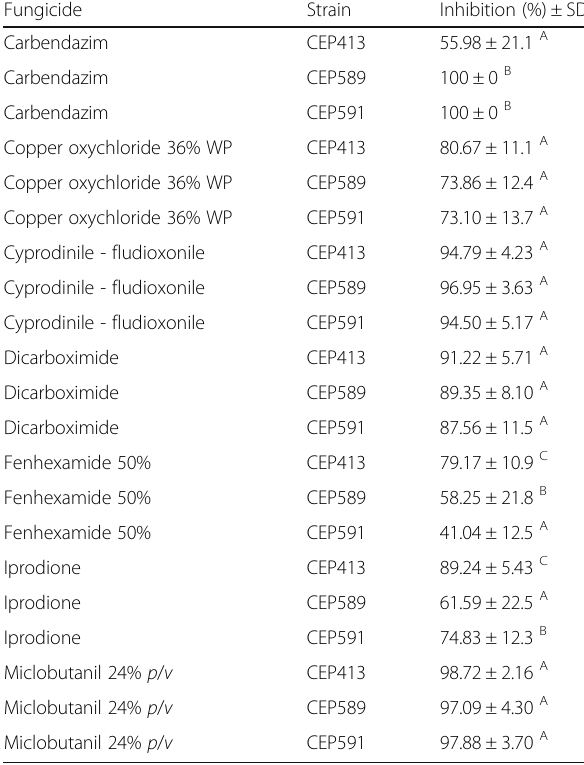
Table 1 Inhibition trials of seven commercial fungicides to access compatibility with three entomopathogenic fungal strains Fungicide